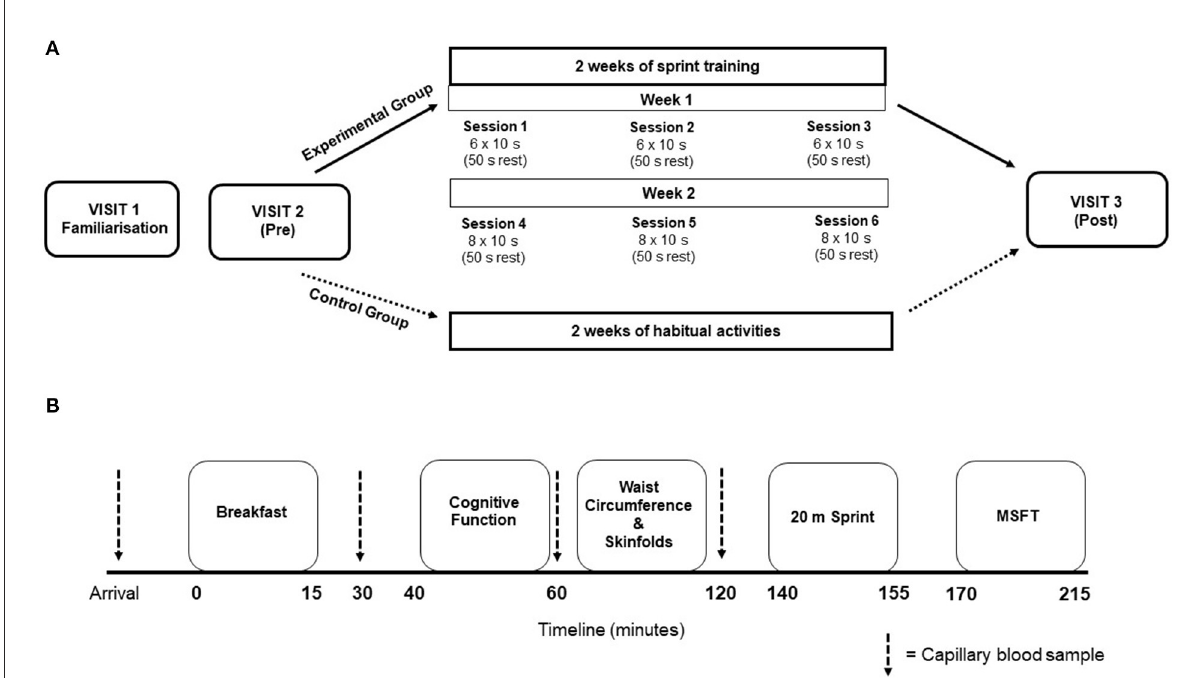
FIGURE1 (A) Schematic representation of the overall study design. Training session details indicate the number of sprints performed. (B) Visual representation for the timeline of measurements during experimental visit’s 2 and 3. Thick dashed lines represent the timing of capillary blood